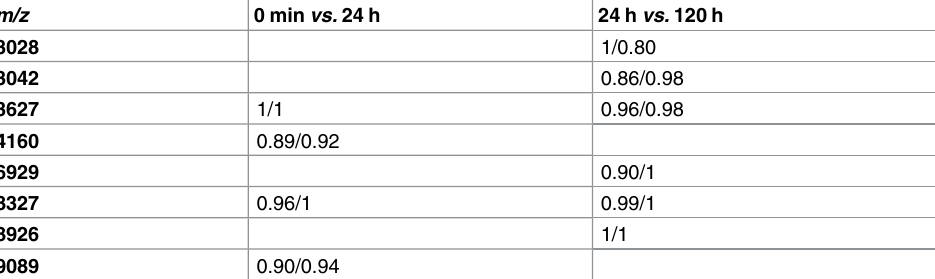
Table 1. AUC determined by ROC curve analysis for each peak used to compare 0 min vs . 24 h (acute phase), and 24 h vs .120h (recoveryphase). m/z 0 min vs. 24 h 24 h vs. 120 h 3028 1/0.80 3042 0.86/0.98 3627 1/1 0.96/0.98 4160 0.89/0.92 6929 0.90/1 8327 0.96/1 0.99/1 8926 1/1 9089 0.90/0.94 Peaks with AUC ≧ 0.8 were listed in the table. Values are given as first cohort/second cohort. The identified peaks were as follows; 3028 (ALB: 25–49, Q - > deamidated: 18), 3042 (ALB: 25–50), 3627 (HBA: 1–36), 8926 (ALB: 25–103). AUC, area under the curve; ROC, receiver operating characteristics; m/z , mass to charge ratio; ALB, albumin; HBA, hemoglobinsubunit α